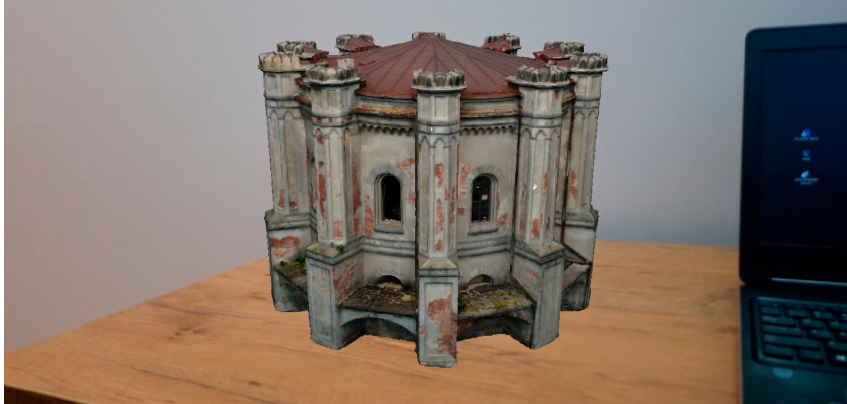
Figure 17. Visualization of the 3D water station building model in prototype AR application superimposed on the desk (100 k model). Sensors 2020 , 20 , x FOR PEER REVIEW